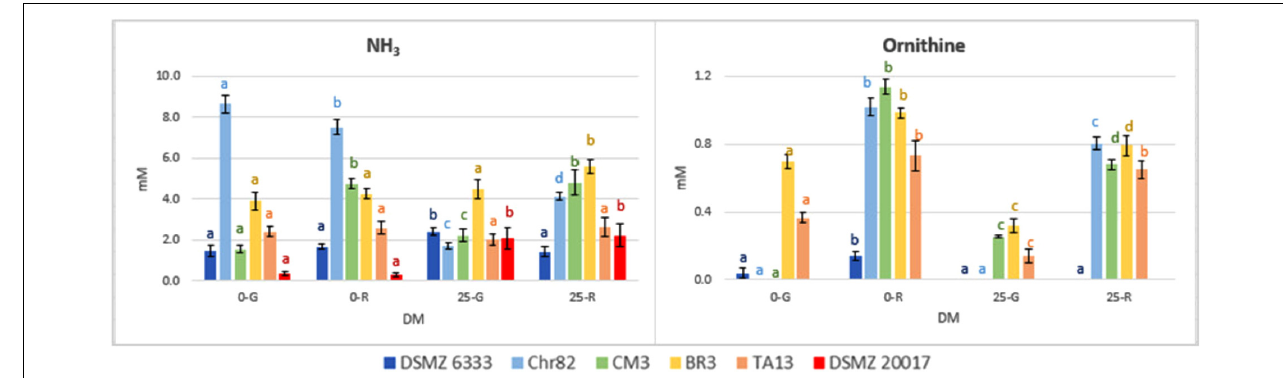
FIGURE 6 | Ornithine and NH 3 concentration in DM (expressed as mM) after 24 h of incubation. The standard deviations are reported. For each strain, different letters indicate significant differences ( P < 0.05) according to